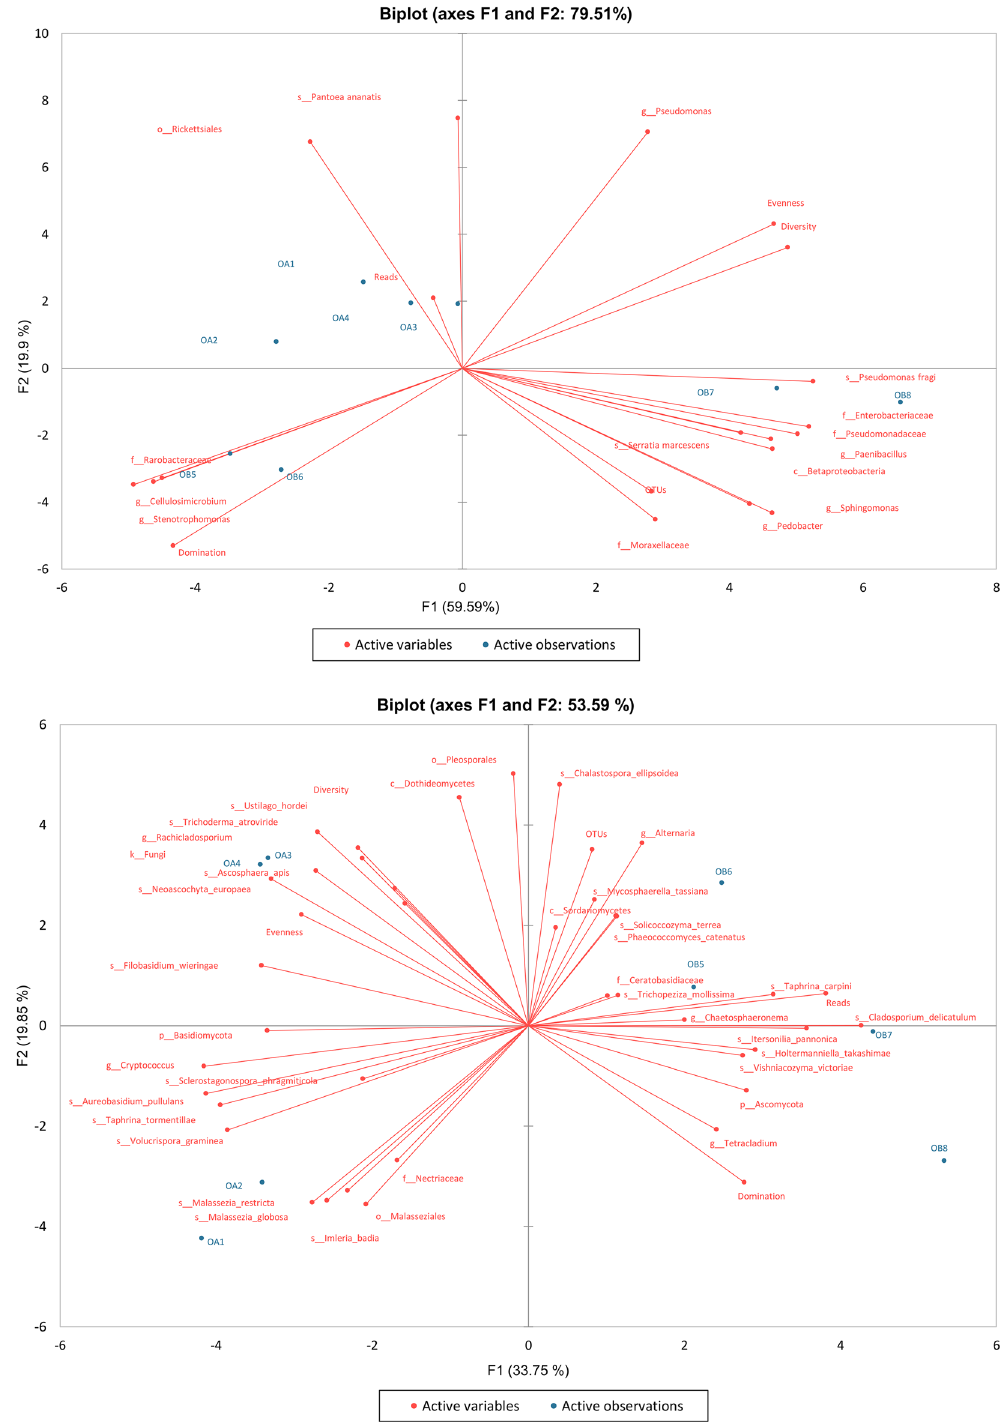
Figure 4. Relation between the most abundant orders of bacteria (top) and fungi (bottom) and their influence on samples of Orobanche alsatica (OA) and O. bartlingii (OB) in immature stigmas from closed flowers (1, 2, 5, 6) and mature stigmas from opened flowers (3, 4, 7, 8), according to